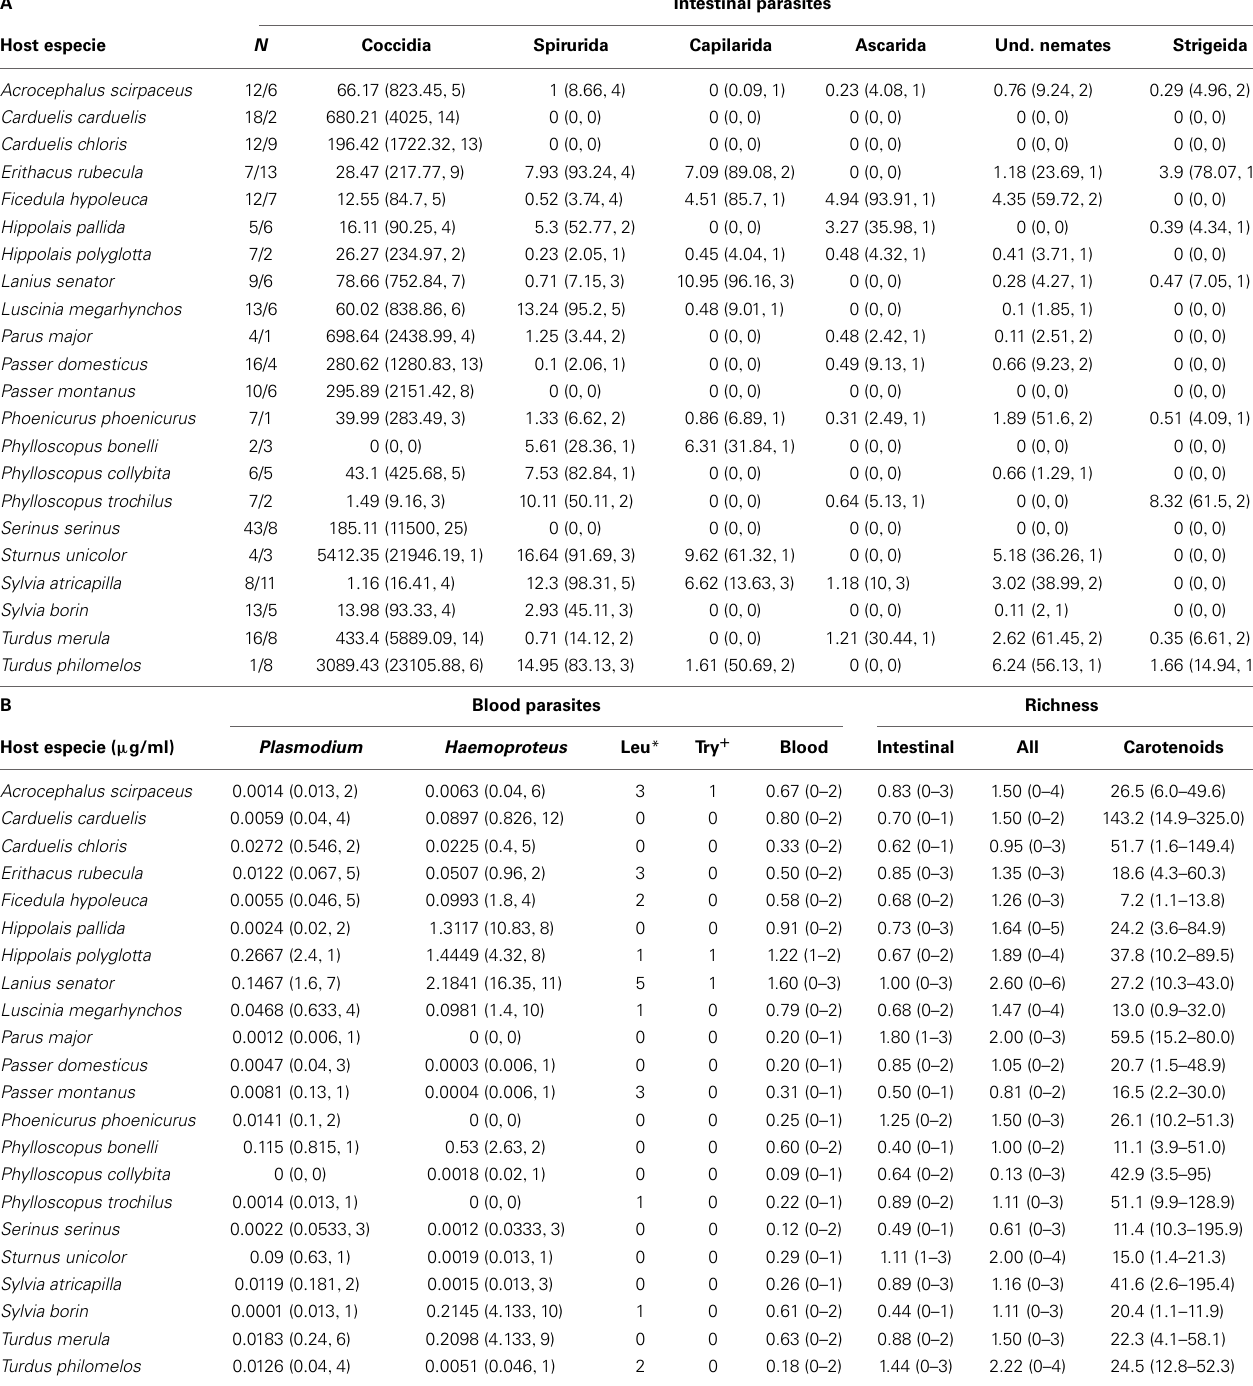
Table 1 | (A) Number of analyzed individuals per species (males/females), abundance of the different intestinal parasite groups (for each parasite the mean abundance, the maximum abundance and the number of infected individuals is given), (B) Abundance of the different blood parasite groups (for each parasite the mean abundance, the maximum abundance and the number of infected individuals is given except for extra-erythrocytic blood parasites, for whom only the number of infected individuals is given), parasite richness (mean number of different parasite groups and range in brackets) and caratoneid concentrations (mean and range in